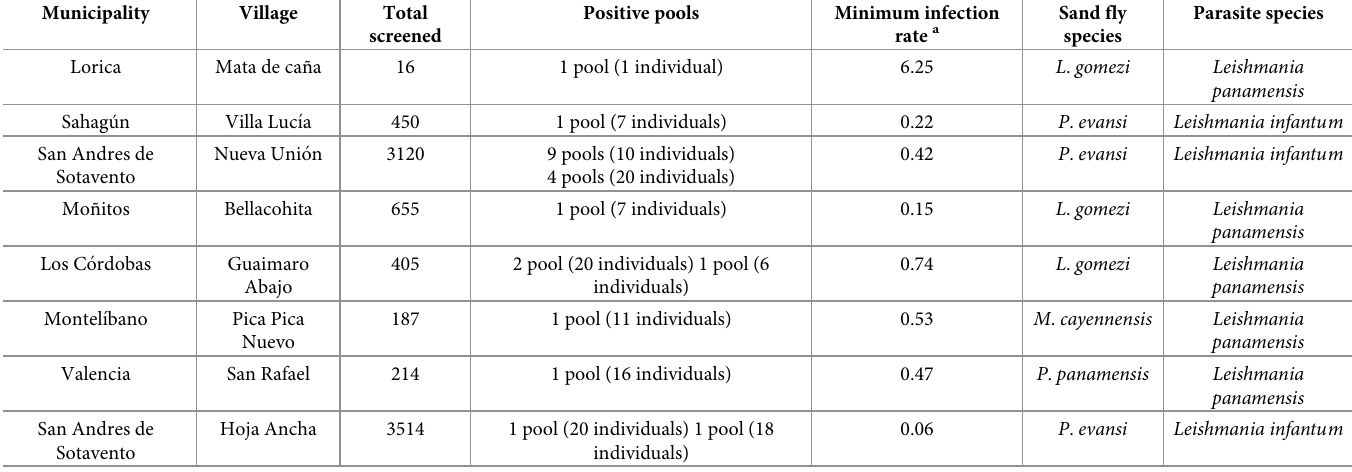
Table 3. Infection results of screened pools. For each sampled village the minimum infection rate (MIR,) the parasite species detected and the infected sand fly species are shown.